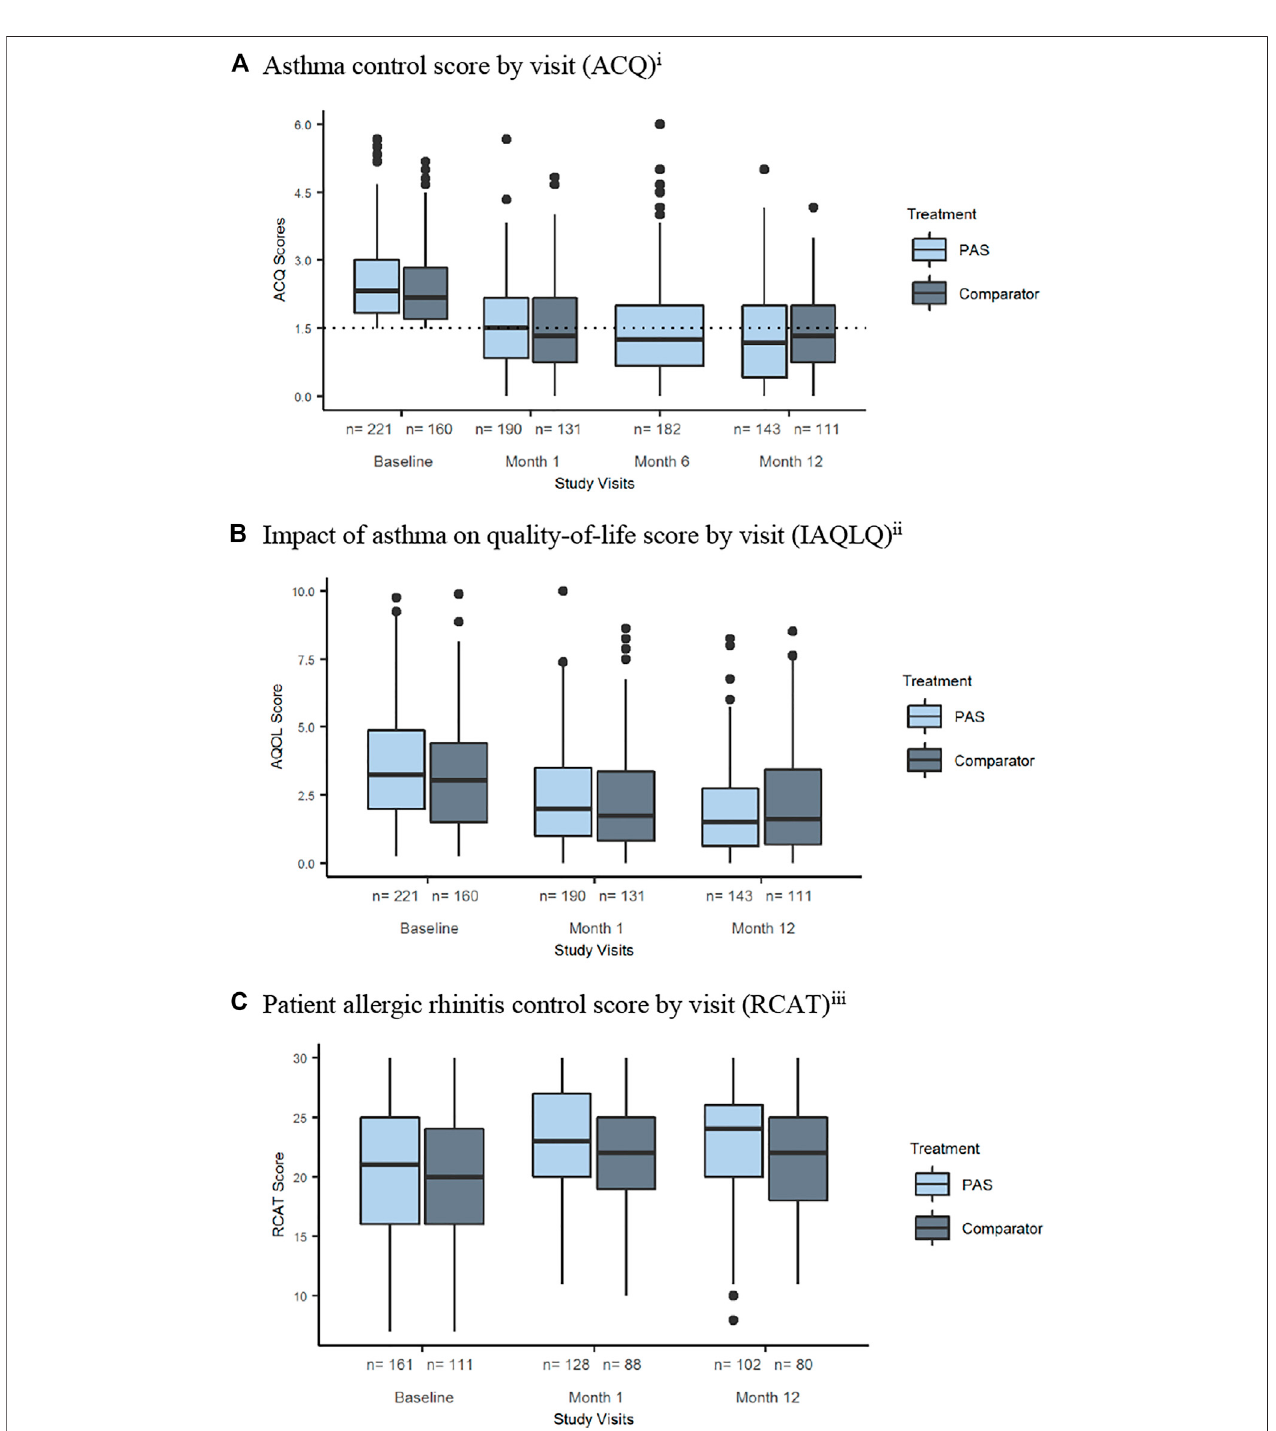
FIGURE 3 | Primary and secondary outcomes. (A) Asthma control score by visit (ACQ) i . (B) Impact of asthma on quality-of-life score by visit (IAQLQ) ii . (C) Patient allergic rhinitis control score by visit (RCAT) iii . Note: i) Asthma Control Questionnaire (ACQ) score lies between 0 (totally controlled) and 6 (extremely poorly controlled). A score of 1.5 or greater is considered an indication of poorly controlled asthma (Juniper et al., 2006) Change in score of 0.5 is considered a clinically signi fi cant change (Juniper et al., 2006) Note no assessment of ACQ at month 6 in comparator arm. ii) The Impact of Asthma on Quality of Life Questionnaire (IAQLQ) scores lie between 0 and 10. Higher scores represent a greater impact of asthma on quality of life (Marks et al., 1992). iii) Rhinitis Control Assessment Test (RCAT) Scores lie between6and 30. Thelower thescore, themore severe theallergic rhinitis; thehigher the score,the less severethe allergicrhinitis. Patients scoring ≤ 21are considered clinically “ symptom uncontrolled ” ; those scoring > 21 were considered “ symptom controlled ” (Meltzer et al., 2013).